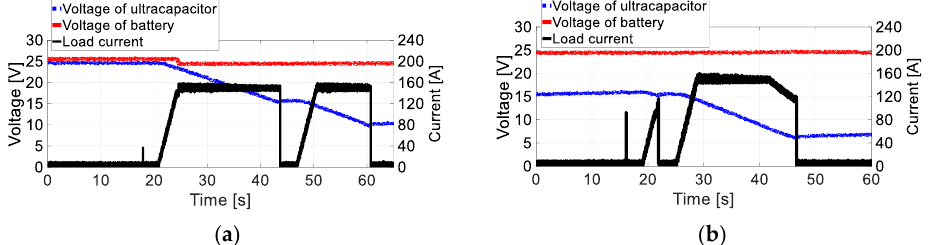
Figure 7. Voltages and currents during load: ( a ) fully charged ESM module; ( b ) partially discharged ESM, in standard conditions (ambient temperature 293 K).